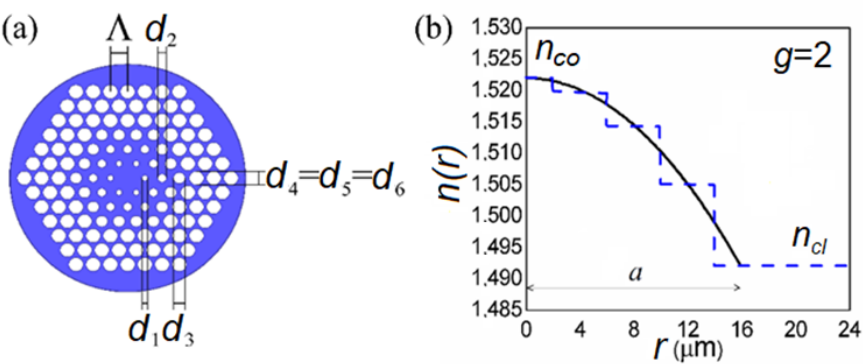
Figure 1. ( a ) The multimode GI MOF’s cross-section. Pitch Λ is used to position the air holes in a triangular lattice. The four inner air-hole rings in the core have the following air-hole diameters: d 1 , d 2 , d 3 , and d 4 . The diameter of the air holes in the cladding in rings 5 and 6 is the same as that in air-hole ring 4 ( d 4 = d 5 = d 6 ). ( b ) The RI performance of the referent multimode GI MOF (blue dashed line). The RI in the core has a parabolic distribution (1) with g = 2 (black solid line). The performance of GI mPOF is substantially impacted by mode coupling. Light